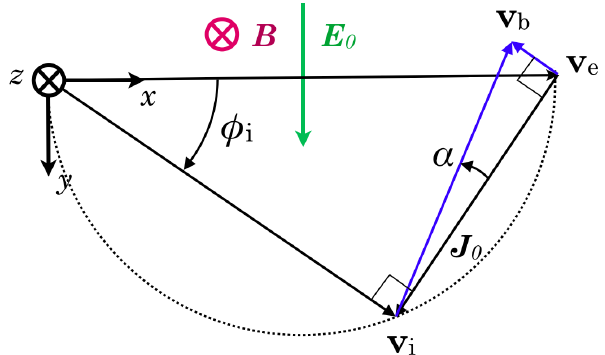
Figure 5. The dashed semicircle shows the locus of v i for various values of κ i . The blue arrows show the construction of v b , the drift of the density enhancement, relative to either the ion or electron background drift, for a modest enhancement ( n (cid:38)